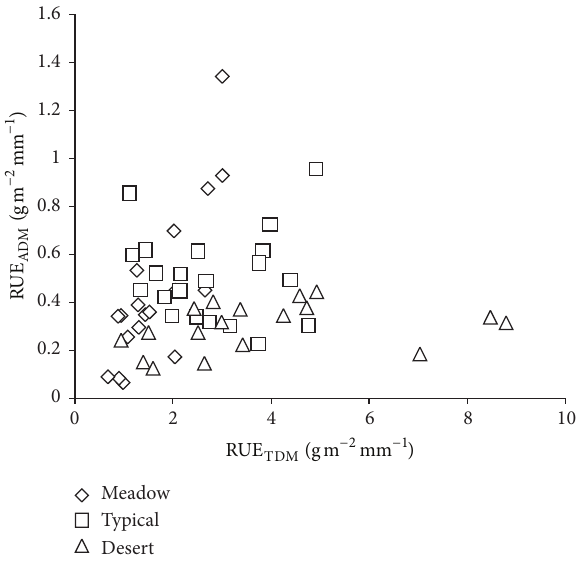
Figure 7: Relationship between RUE ADM (gm −2 mm −1 ) and RUE TDM (gm −2 mm −1 ) in meadow steppe, typical steppe, and desert steppe across the grassland of Inner Mongolia. RUE ADM = rain use efficiency based on above ground dry matter, RUE TDM = rain use efficiency based on total dry matter.